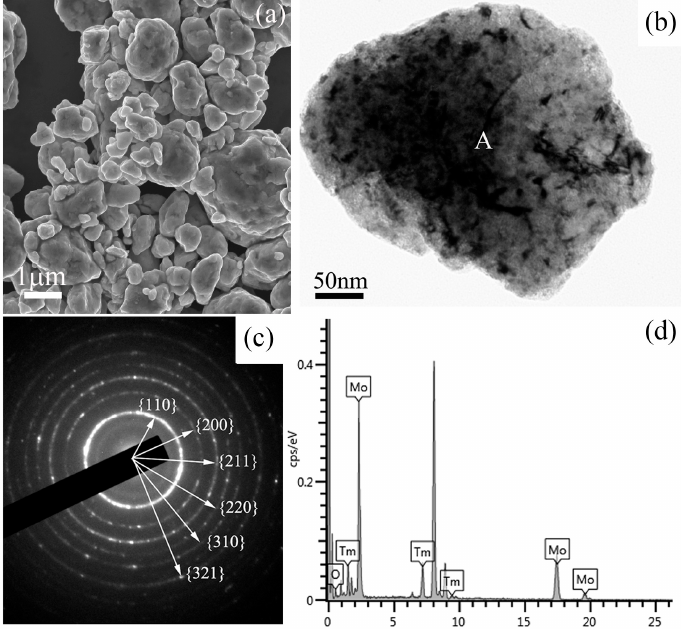
Figure 3. Microstructure analysis results of Mo (21 wt %) Tm 2 O 3 powder mixtures milled for 48 h; ( a ) SEM image showing the morphology of the ball-milled powders; ( b ) bright field TEM image; ( c ) selected area electron diffraction pattern from region ‘A’ in ( a ) showing the Mo phase; and ( d ) EDS analysis results from region ‘A’ in ( a ) showing the diffraction peaks of Tm, Mo, O, and Cu elements. Cu peaks comes from the copper grid.